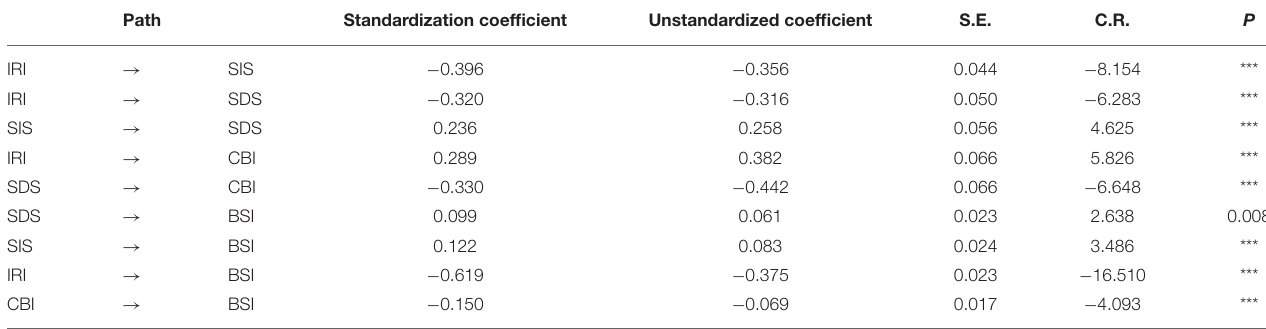
TABLE 4 | Path analysis of the effects of social workers’ empathy ability (IRI) on patients’ suicide ideation (BSI) at T2. Path Standardization